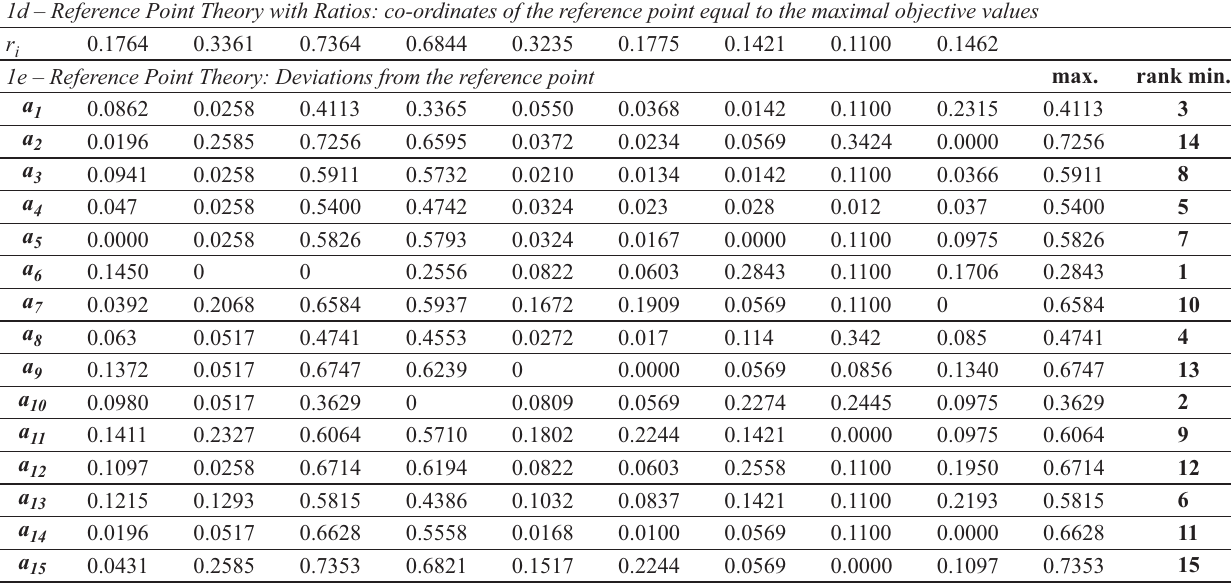
Table 1 – MOORA applied on 9 objectives for Lithuanian contractors. Reference Point Part 1d – Reference Point Theory with Ratios: co-ordinates of the reference point equal to the maximal objective values r i 1e – Reference Point Theory: Deviations from the reference